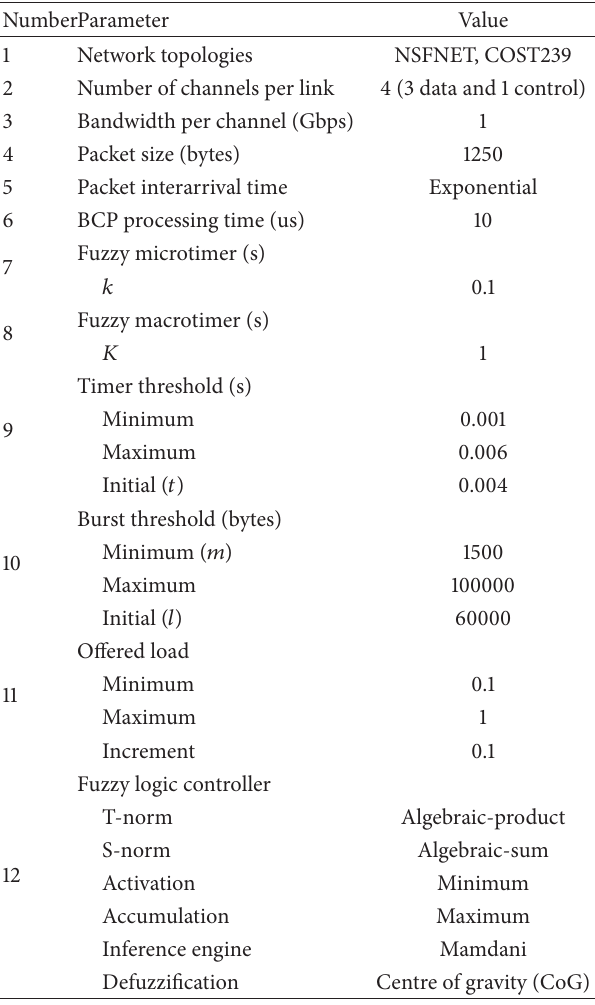
Table 2: Fuzzy rules. Table 3: Simulation parameters and